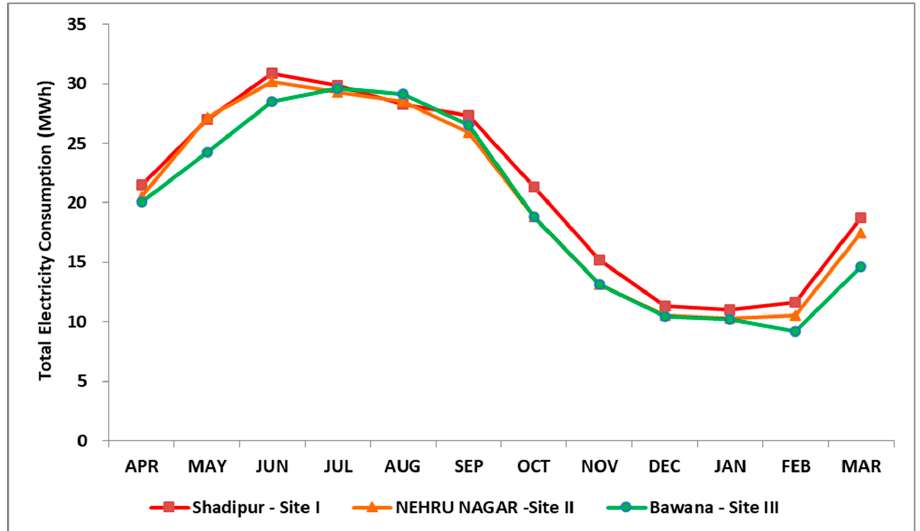
Table 5. Simulation sites and annual electricity consumption and cooling load details.